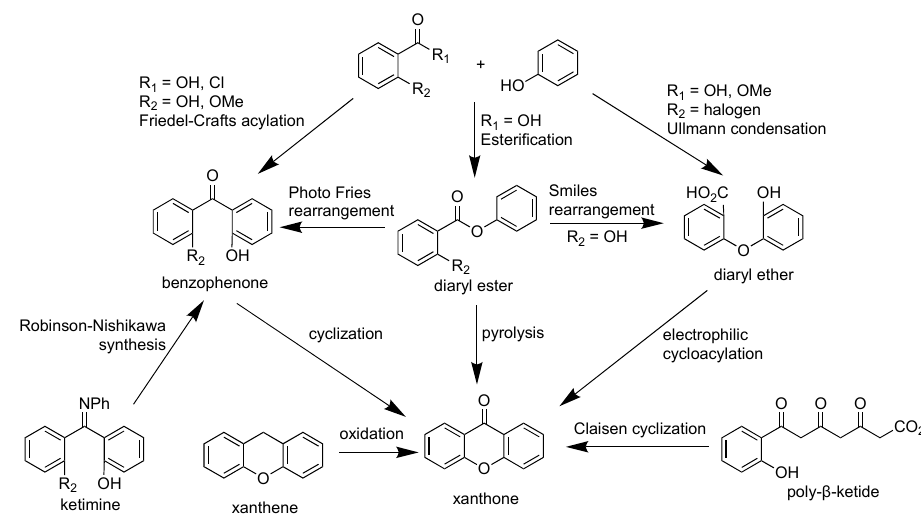
Figure 6. Brief synthetic scheme of xanthone derivatives.